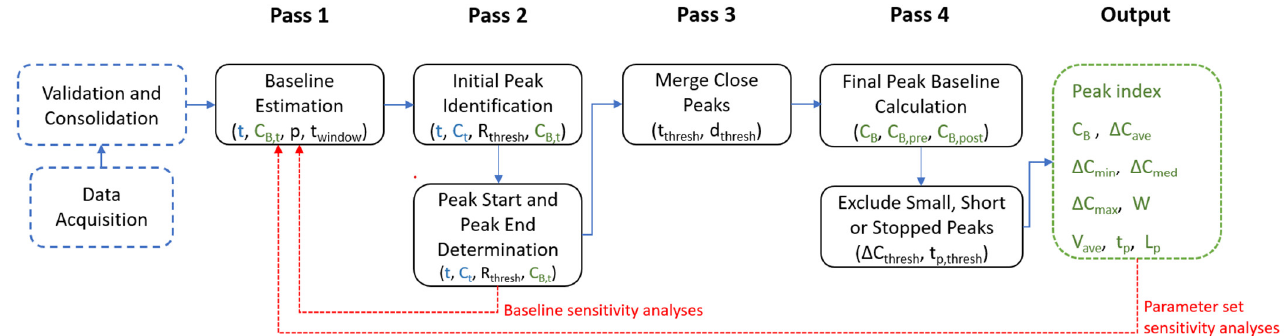
Figure 1. Flow chart of the peak detection algorithm. Blue parameters are MPAL measurements, black are algorithm parameters discussed in this study, and green are calculated/output values. Similarly, blue boxes show steps of input data processing, black boxes show algorithm steps, and the green box indicates data output. Red lines represent baseline and sensitivity analyses.